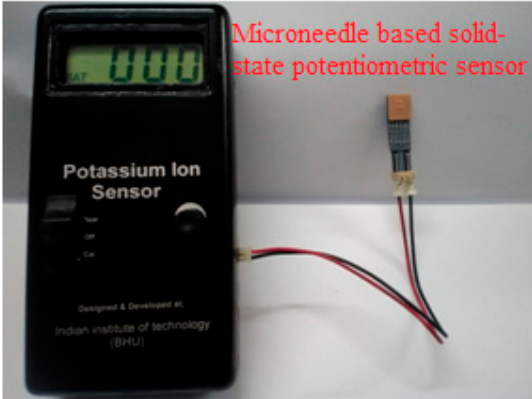
Figure 10. Construction of a microneedle assembly-based screen-printed electrode (SPE)-based potentiometric potassium ion sensor